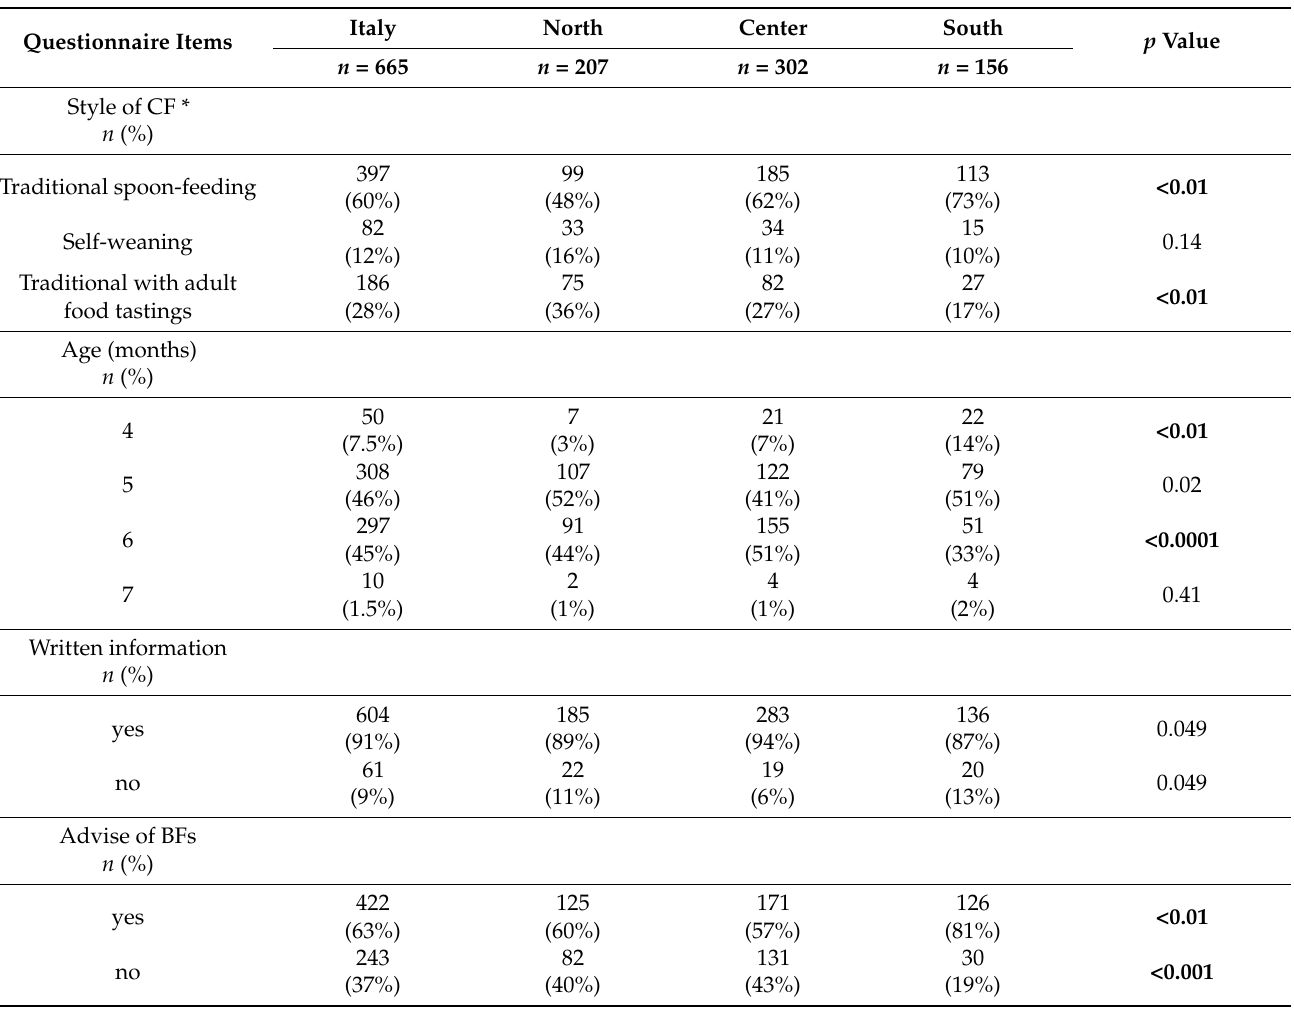
Table 3. Answers of care primary pediatricians and differences based on the area of